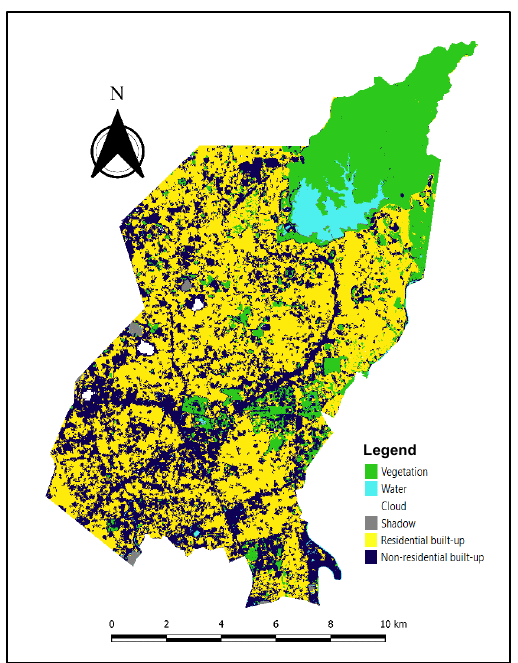
Figure 12. Best-performing Level 2 output (81.56% OA) showing land use land cover in Quezon City, with two classes of built-up areas: residential and non-residential.